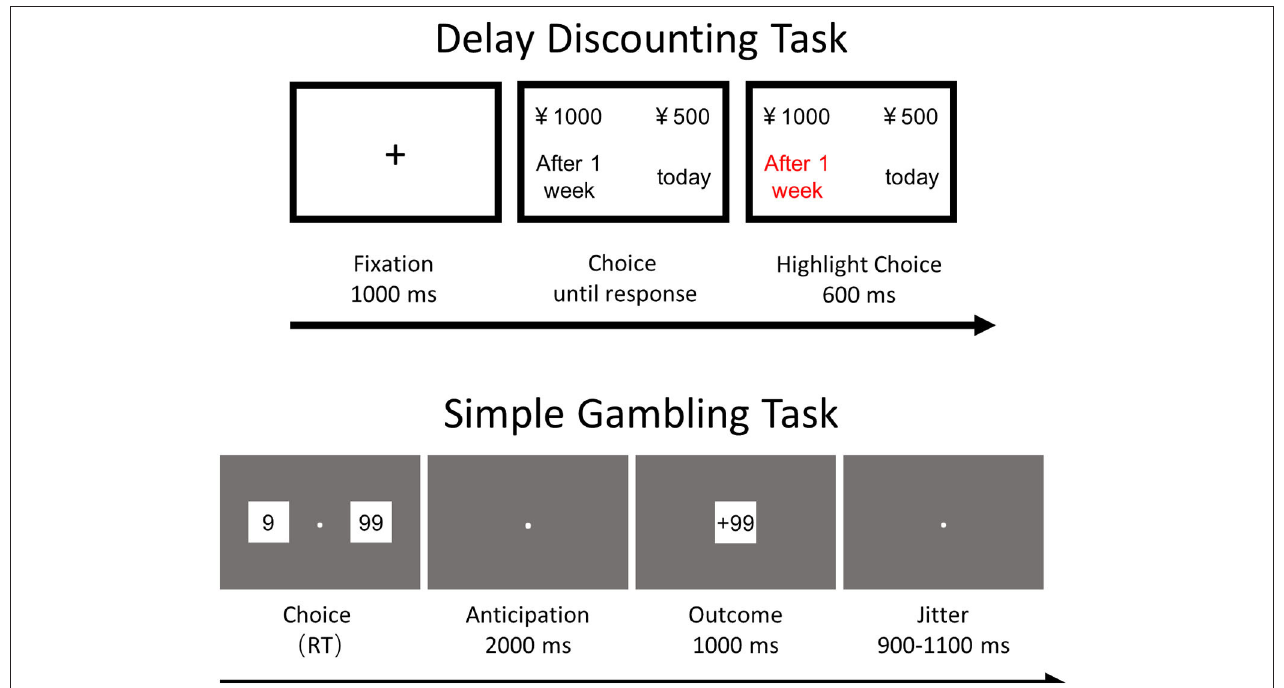
FIGURE 1 | The experiment design of the delay discounting task and the simple gambling